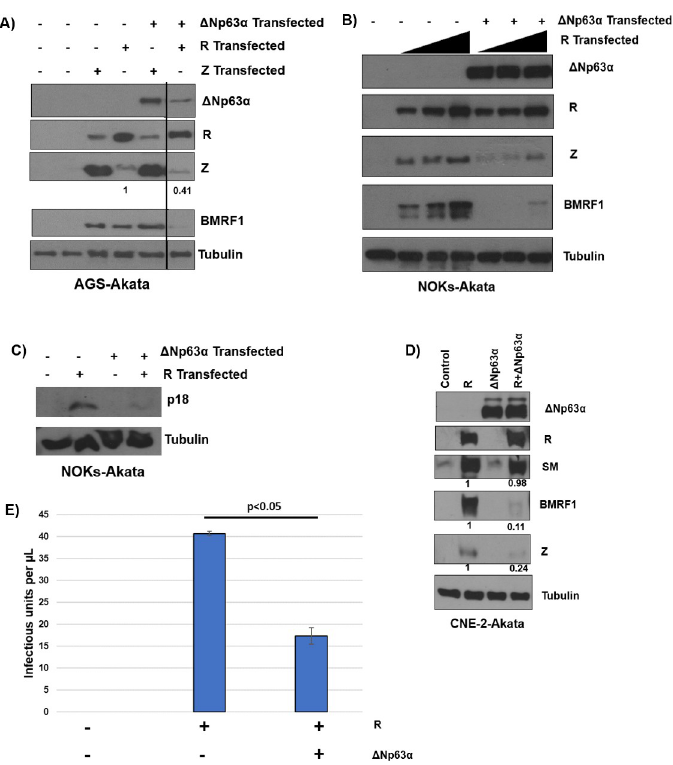
Fig 4. Δ Np63 α over-expression inhibits R-mediated, but not Z-mediated, lytic reactivation. A) AGS-Akata cells were transfected with Z or R expression vectors, with or without a co-transfected Δ Np63 α expression vector. Immunoblots were performed to assess expression levels of the EBV lytic proteins Z, R, and BMRF1 as indicated, as well as the loading control, tubulin. Z expression was quantitated by ImageJ software, normalized to tubulin and the Z alone condition was set as 1. B) NOKs-Akata cells were transfected with 5 ng, 10 ng, or 50 ng of an R expression vector with or without a co-transfected Δ Np63 α expression vector. Immunoblot was performed to examine expression levels of the EBV lytic proteins Z, R, and BMRF1, as well as Δ Np63 α and tubulin as indicated. Note that the western shown is a very short exposure to only capture expression of transfected (but not endogenous) Δ Np63 α . C) NOKs-Akata cells were transfected with 10 ng of an R expression vector with or without a co-transfected Δ Np63 α expression vector or the Δ Np63 α expression vector alone (same extracts as in Fig 4B) and an immunoblot was performed to examine expression of the late viral protein, viral capsid protein p18. Tubulin was used as a loading control. D) CNE-2-Akata cells were transfected with an R expression vector in the presence or absence of a co-transfected Δ Np63 α vector. An immunoblot was performed to examine expression levels of the Δ Np63 α , R, Z, BMRF1, SM, and tubulin proteins as indicated. SM, BMRF1, and Z expression was quantified using ImageJ, normalized to tubulin, with the R transfected by itself set as 1. The black line in Fig 4A shows where irrelevant lane(s) were removed; the original western blots used to construct Fig 4A are shown in supplemental Fig 4. The short exposure shown detects expression of transfected (but not endogenous) Δ Np63 α . E) CNE-2-Akata cells were transfected with control vector, an R expression vector, or R plus Δ Np63 α expression vectors. Three days after transfection infectious virus titers in each condition were quantitated as described in the methods. All results depicted have been independently confirmed a minimum of two